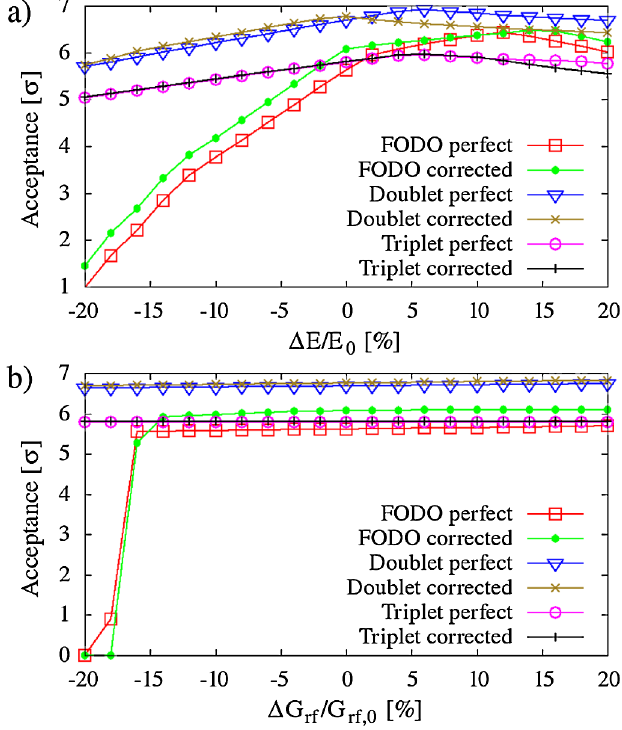
FIG. 11. Acceptance of the lattices, (a) for different initial beam energy and (b) for different accelerating